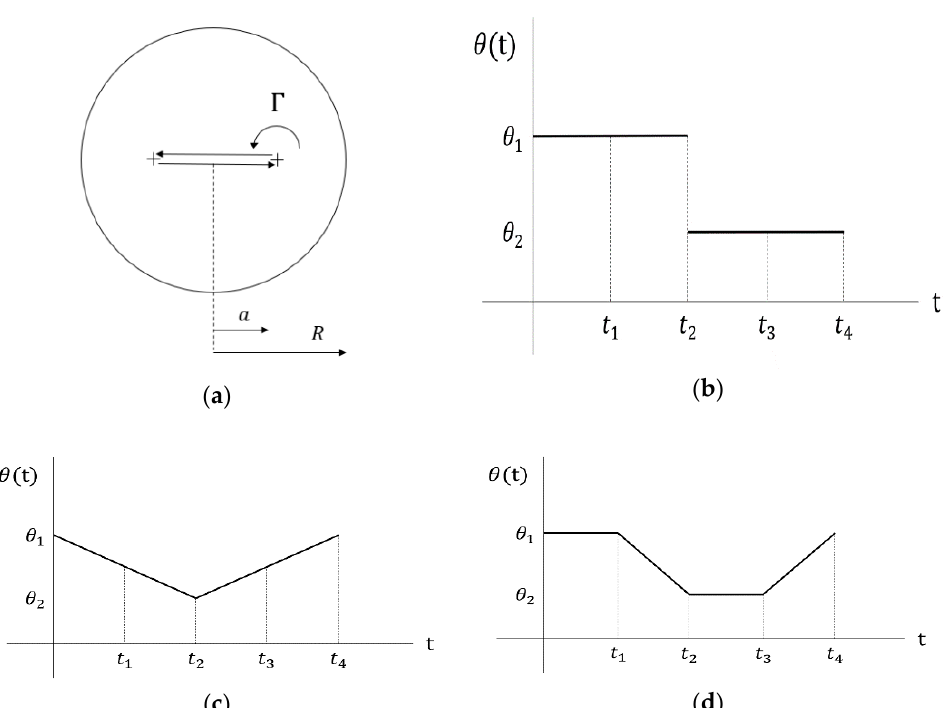
Figure 1. A schematic diagram of ( a ) Aref’s blinking vortex model with moving vortex and the angle of velocity with respect to the positive x-axis for ( b ) Aref’s blinking vortex model with motion of the point vortices between the fixed points of the original vortex positions; ( c ) pure transition model; and ( d ) a system with fixed and moving vortices. Γ , a , and R are vortex strength, vortex centre, and domain radius, respectively, and the arrows indicate the direction of the vortex or the trajectory of the moving vortex. A period from 0 to t 4 is not (necessarily) equally divided, but t 1 and t 3 − t 2 are identical and t 2 is half of t 4